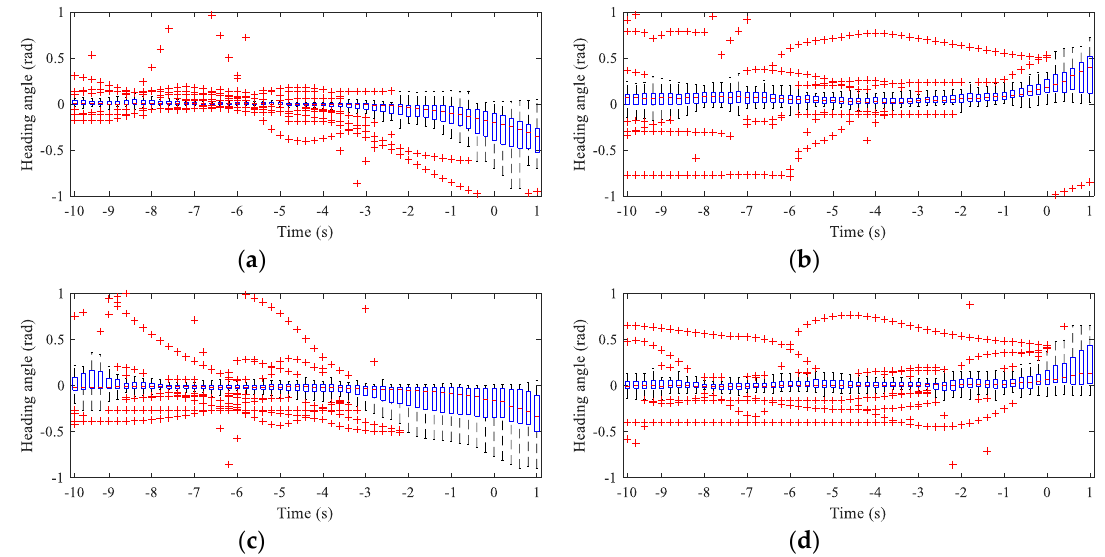
Figure 10. Boxplot of heading angles of the vehicles in Lankershim and Peachtree dataset. ( a ) Statistics of the TL heading angle in the Lankershim dataset. ( b ) Statistics of the TR heading angle in the Lankershim dataset. ( c ) Statistics of the TL heading angle in the Pearchtree dataset. ( d ) Statistics of the TR heading angle in the Pearchtree dataset.